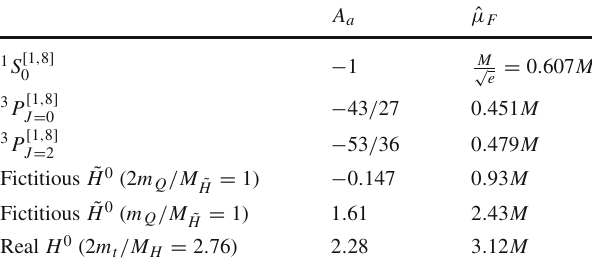
Table 1 The process-dependent constants A a along with the μ F value cancelling the HE limit. For the quarkonia, A a is identical for CS and CO states. For the scalar particles, these values have been derived from the HE expressions of [51]. [ M represents here, and in what follows, the mass of the produced particle, be it a quarkonium or an elementary scalar boson] A